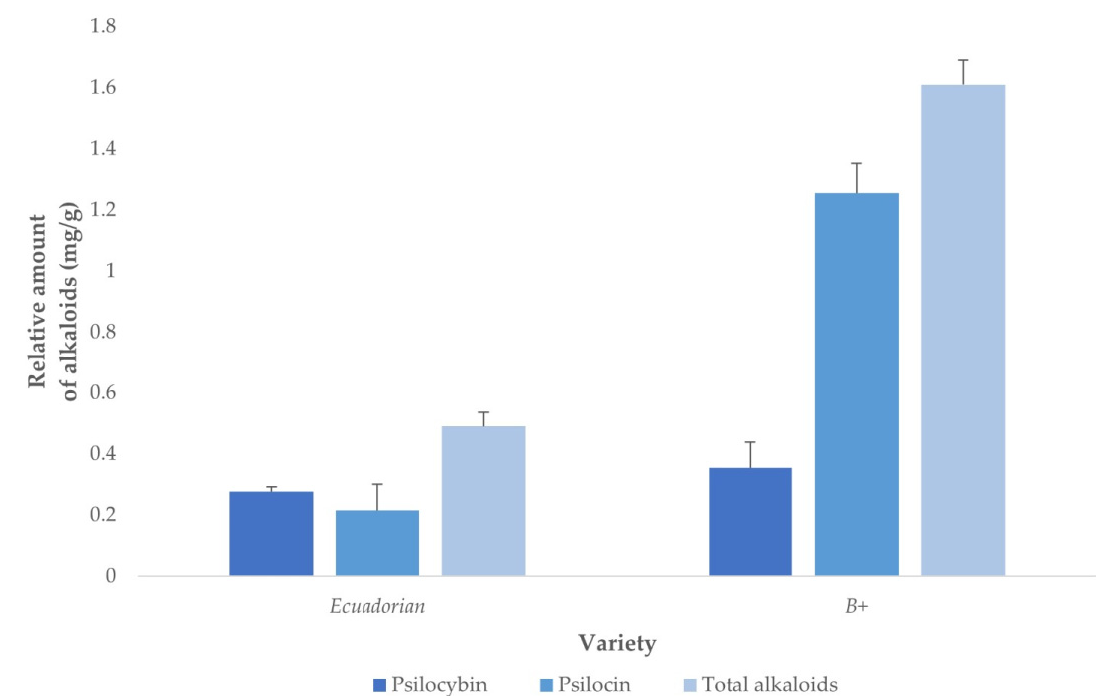
Figure 8. Psilocybin, psilocin and total alkaloid yields obtained through the application of the optimized MAE method to fungal samples of Ecuadorian and B+ varieties ( n = 8).